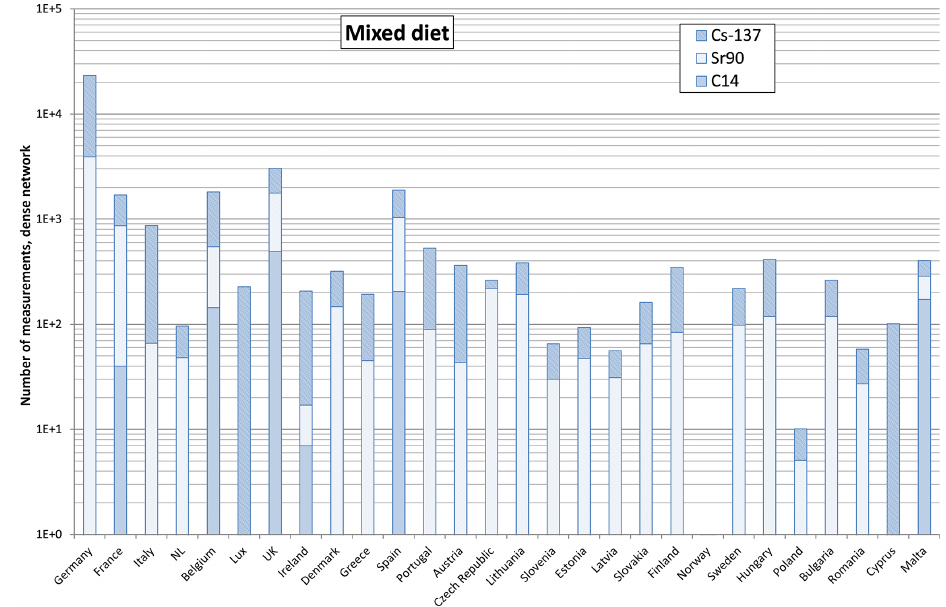
Figure 11. Number of measurements in REMdb for sample type mixed diet, 137 Cs, 90 Sr and 14 C, by country, as recommended in 2000/473/Euratom